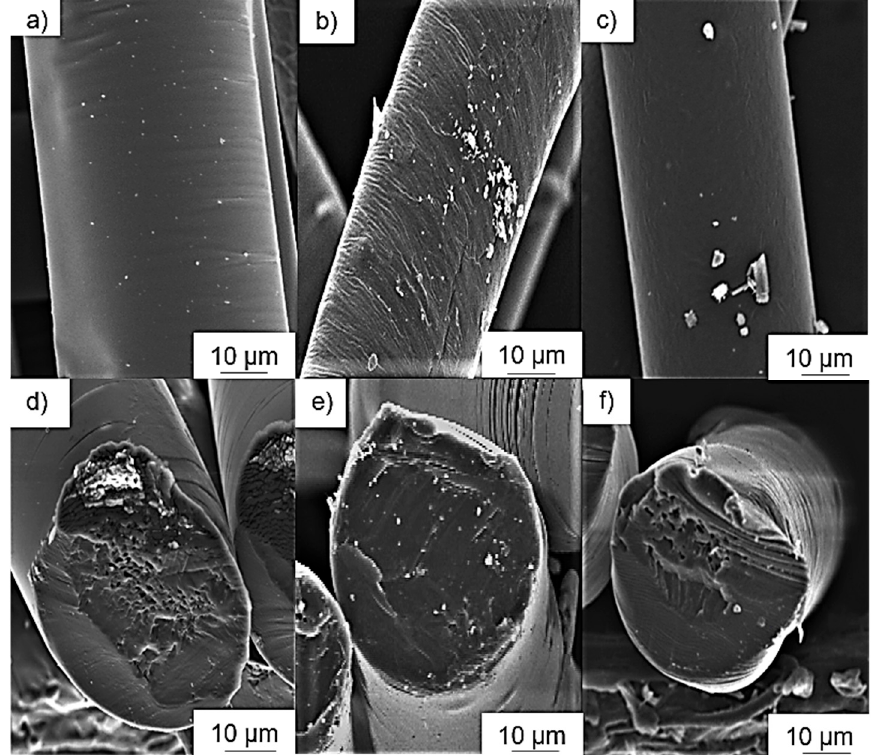
Figure 12. Scanning electron micrographs of PLA composite fibers: ( a ) A3, ( b ) B3, ( c ) G3, ( d ) I3, ( e ) P3, and ( f ) Y3.